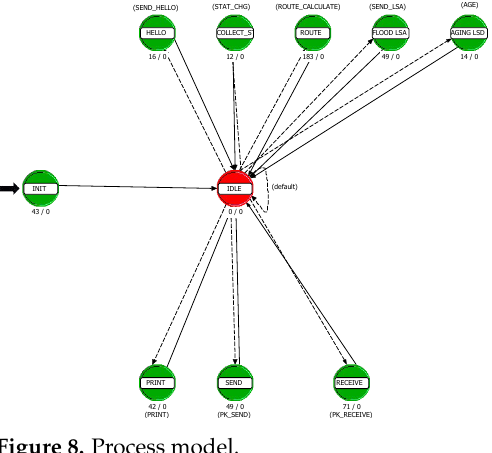
Figure 8. Process model.